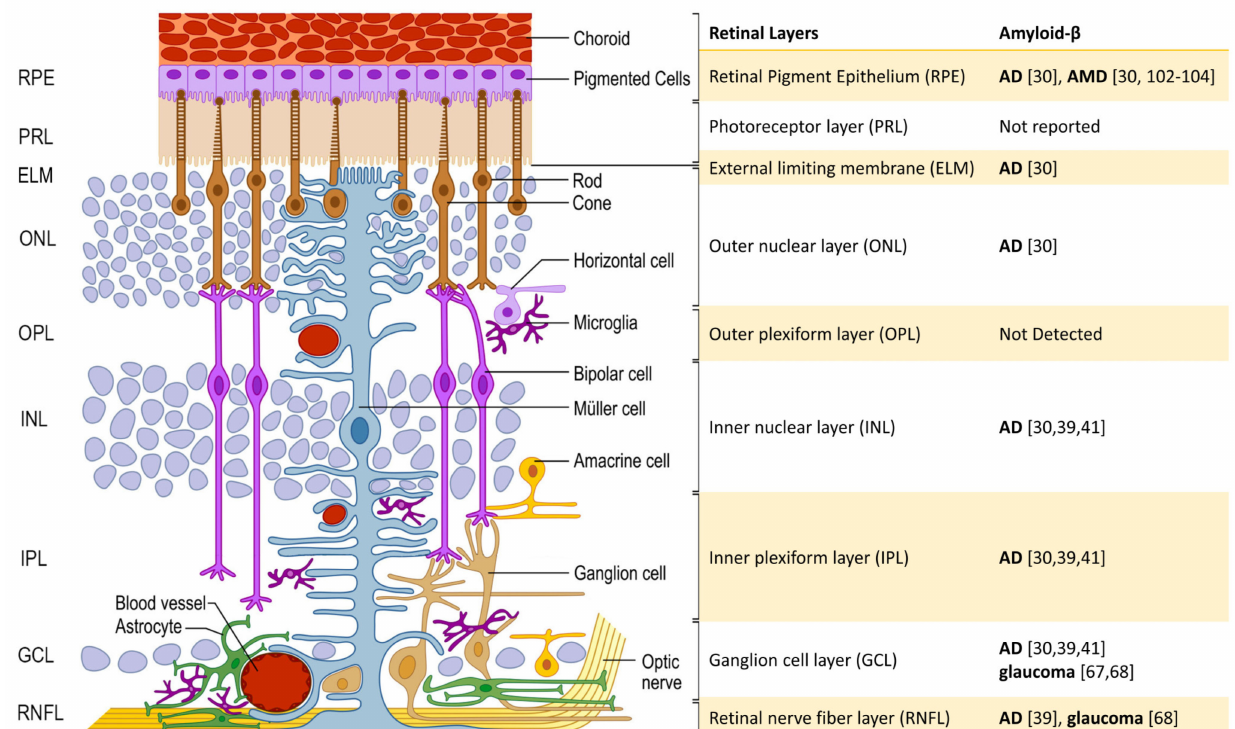
Figure 2. Amyloid- β (A β ) accumulation in the retinal layers for Alzheimer’s disease (AD), glaucoma, and age-related macular degeneration (AMD) in human and primate studies. Structurally, the neuroretina is made up of distinct layers. The inner retina is composed of the inner limiting membrane (not labeled), retinal nerve fiber layer (RNFL), ganglion cell layer (GCL), inner plexiform layer (IPL), inner nuclear layer (INL), outer plexiform layer (OPL), outer nuclear layer (ONL), and external limiting membrane (ELM). The outer retina contains the photoreceptor layer (PRL) and retinal pigment epithelium (RPE). The retina has distinct alternating layers of synapses (e.g., IPL and OPL) and cell bodies (e.g., GCL, INL, ONL) of neurons (blue) and glial cells [25]. A β accumulations are found broadly throughout the retinal layers including within and around neurons and their supporting cells for AD [30,39,41]. For glaucoma, A β elevations are more concentrated in the GCL, which includes the beginnings of the optic nerve that are composed of axons of the retinal ganglion cells [67,68]. AMD-associated A β deposits are mostly reported within and around the RPE, which allows recycling and maintenance of photoreceptor cells (rods and cones) [30,102–104]. (Cited and modified from [120], used under an open-access license